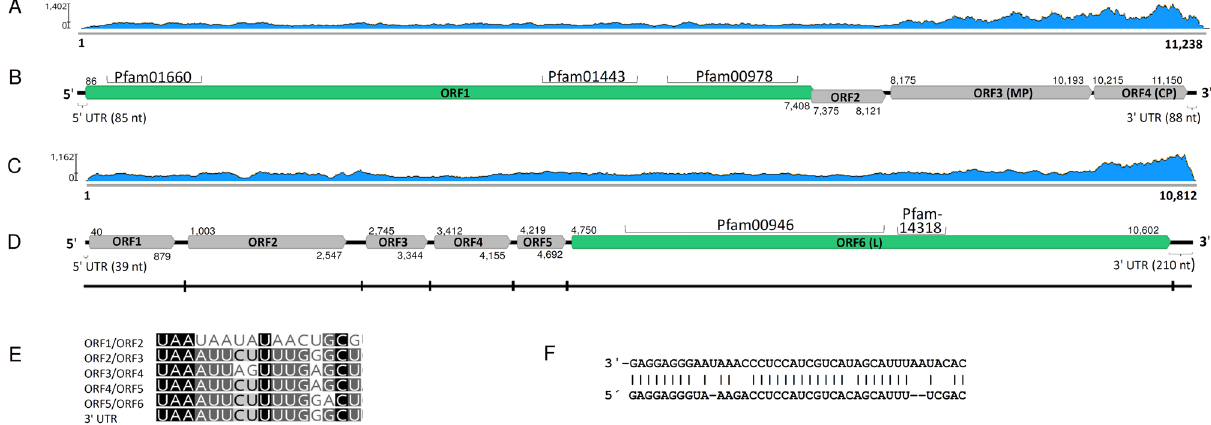
Figure 1. Genome organization of the Armillaria borealis mycovirgavirus 1 (AbMV1) and Armillaria mellea negative strand RNA virus 1 (AmNSRV1). ( A ) Coverage of raw reads mapped against the AbMV1 genome (without poly(A) tail). ( B ) Schematic presentation of AbMV1 genome with UTRs, predicted ORFs and conserved motifs: pfam00978 (RdRP domain, e-value 2.07e−72), pfam01660, (methyltransferase, e-value 1.92e−20) and pfam01443 (helicase, e-value 1.02e−24). Predicted translation initiation and termination sites are marked above or below each ORF. ( C ) Coverage of raw reads mapped against the AmNSRV1 genome. ( D ) Schematic presentation of AmNSRV1 genome with UTRs, predicted ORFs and conserved motifs: pfam00946 (Mononegavirales RdRP, e-value 1.10e−95) and pfam14318 ( Mononegavirales mRNA-capping region V, e-value 4.82e−16). Predicted translation initiation and termination sites are marked above and below each ORF, respectively. The small vertical lines in the virus genomic segment show the location of the putative gene junction sequences. ( E ) Consensus sequences (uracil-rich tracts) of putative gene junction regions between the predicted ORFs in 3 ′ > 5 ′ orientation (genomic RNA). ( F ) Complementarity in the 5 ′ - and 3 ′ -terminal sequences in the genomic RNA